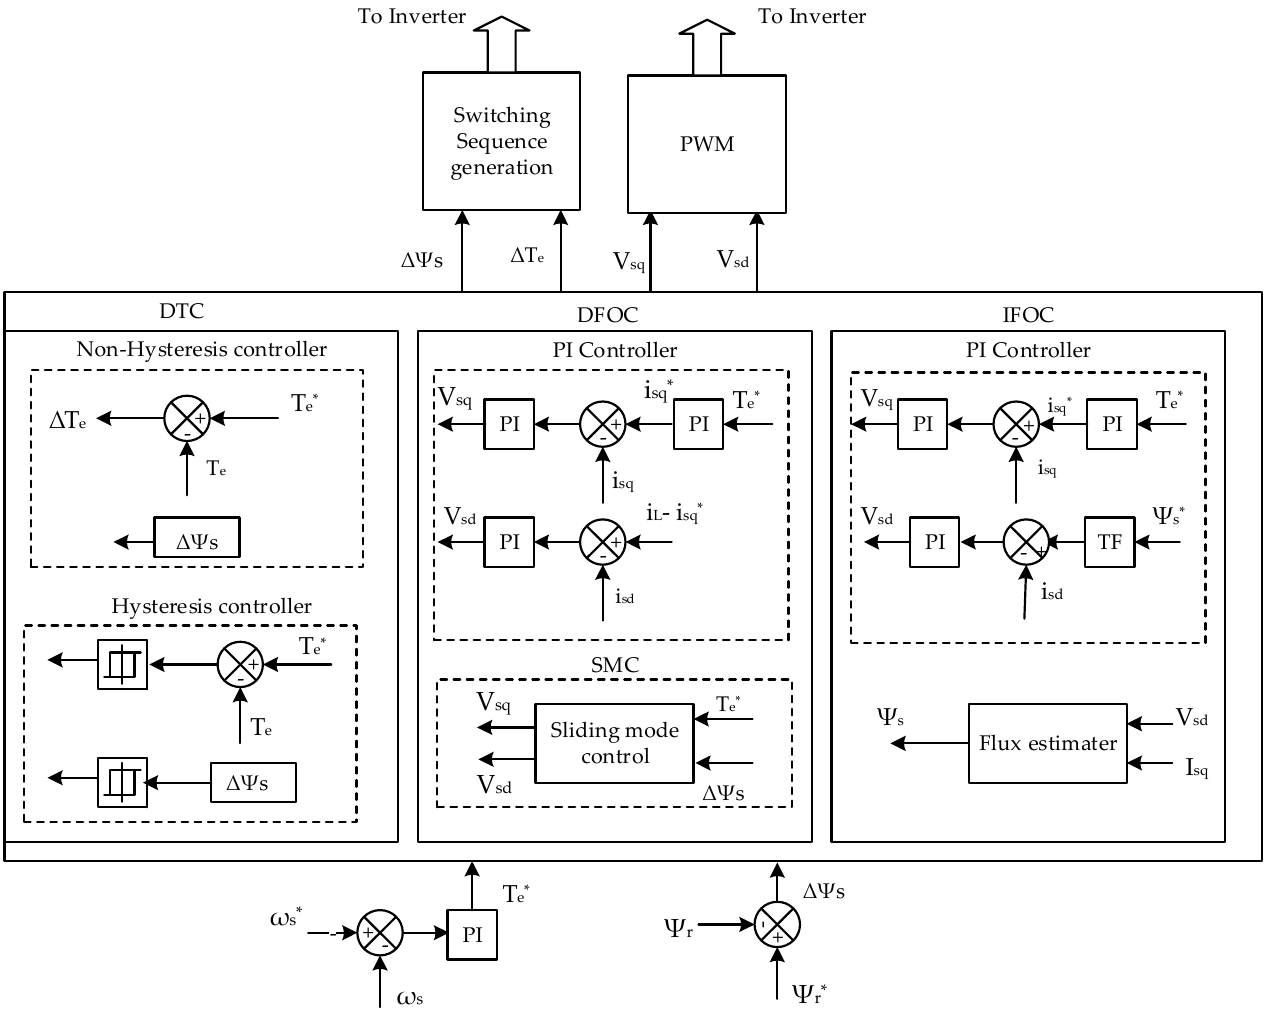
Figure 2. Control strategies for IM-based EV system.